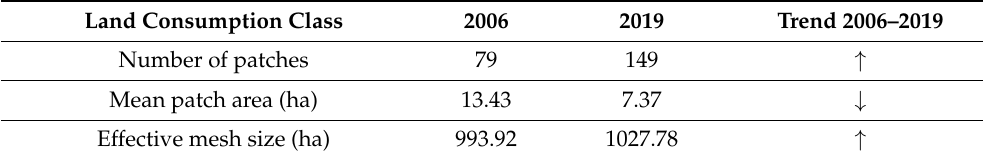
Figure 5. Land consumption and natural capital flow in 2006 ( a ), 2011 ( b ), and 2019 ( c ). In ( d ) land consumption 2006–2019 has been classified in terms of the lost capacity shown by consumed patches to provide natural capital flow. Table 3. Landscape metrics to analyze the spatial configuration of the areas characterized by land consumption. In the range 2006–2019 ↑ indicates increasing trend while ↓ decreasing